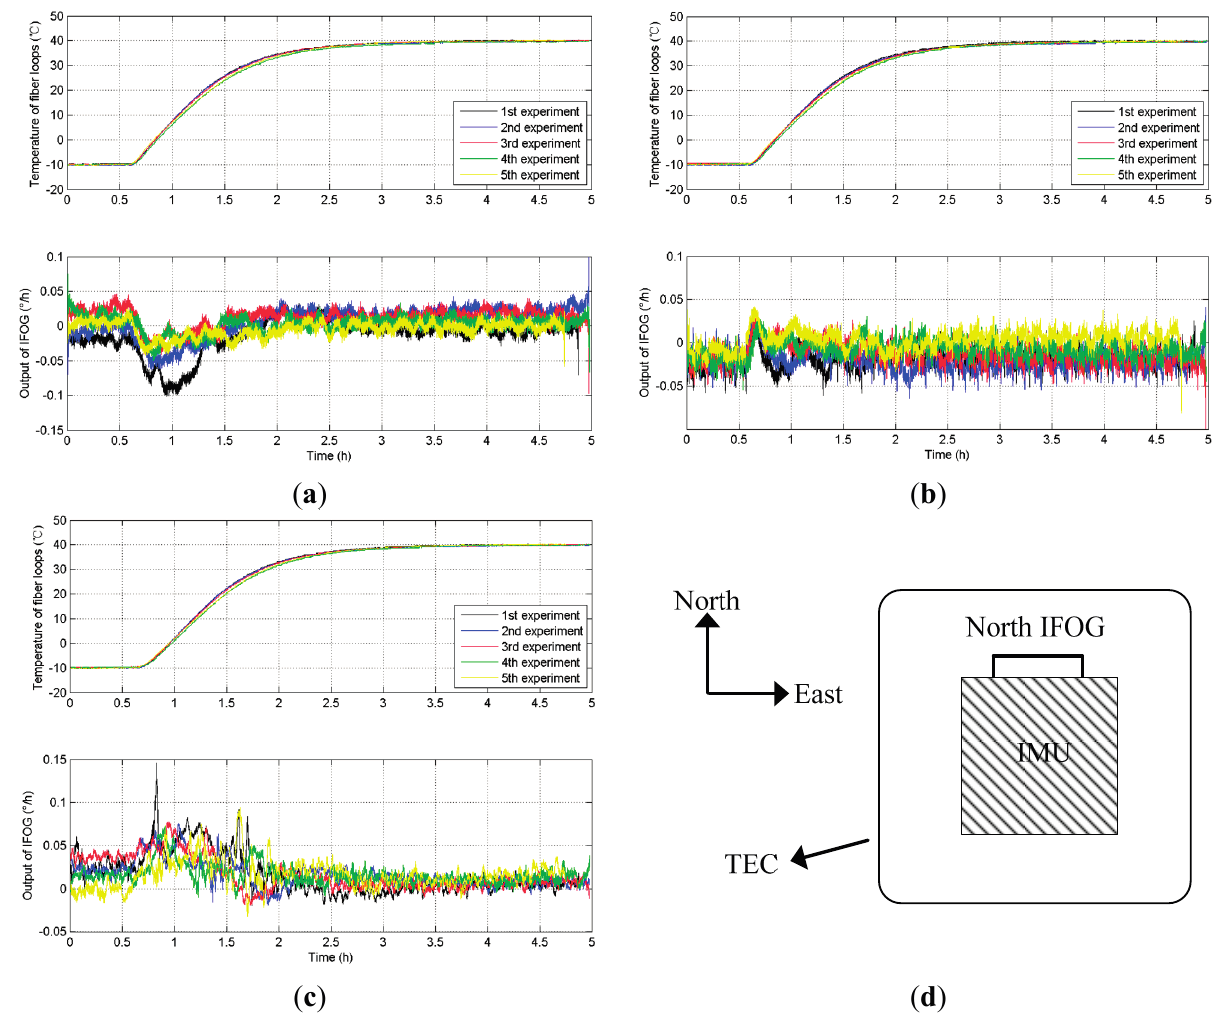
Figure 6. Five groups of fiber loop temperatures and IFOG outputs. ( a ) Test results from NO.1 IFOG; ( b ) Test results from NO.2 IFOG; ( c ) Test results from NO.3 IFOG; ( d ) The placement of the tested